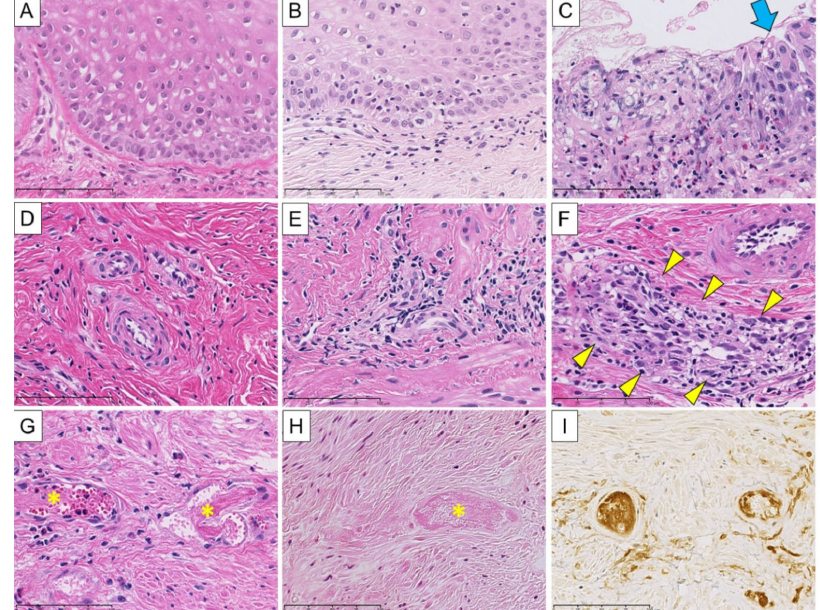
Figure 2. Histologic variables of cellular and humoral rejection in cynomolgus macaques following uterus transplantation. ( A ) Normal squamous epithelium of the cervix < E0 > . ( B ) Focal vacuolar alteration of the basal cell layer with mild junctional lymphocytic infiltrates < E1 > . ( C ) Desquamative arrow < E3 > . ( D ) Blood vessels and fibromuscular stroma with no significant inflammation < S0